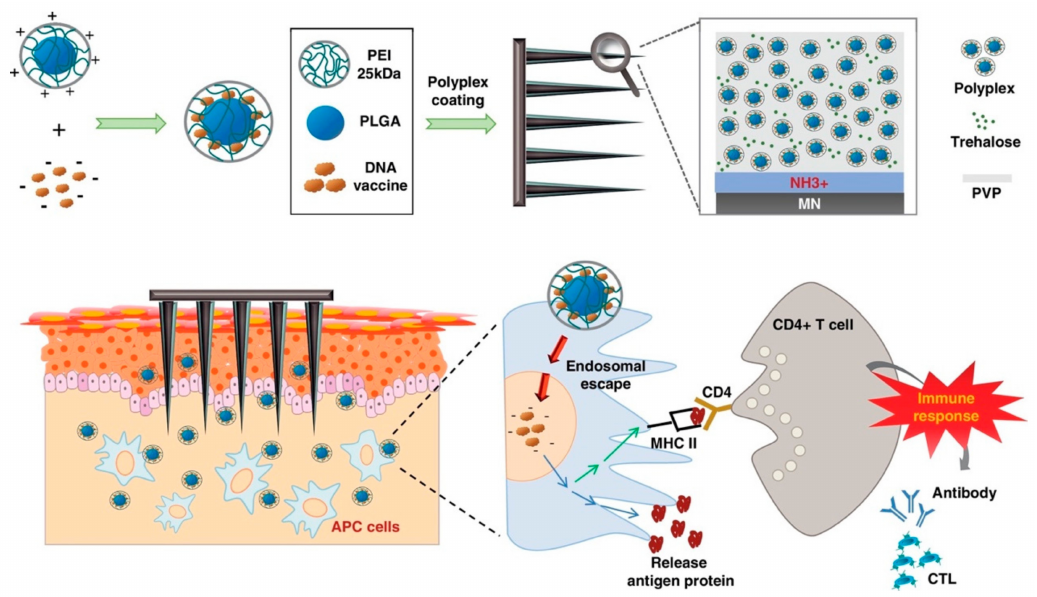
Figure 5. Illustration of PLGA / PEI / pH1NI polyplex coated-stainless steel microneedles for intradermal vaccination. The microneedle system delivers the nanoparticle-DNA complexes across the stratum corneum, into the immune cell-rich region of the epidermis. This facilitates the targeted transfection of antigen-presenting cells that activate cytotoxic T lymphocytes via MHC molecules, stimulating the induction of cell-mediated and humoral immunity to the target disease. Reprinted with permission from H Seok, Journal of Controlled Release, published by Elsevier, 2017